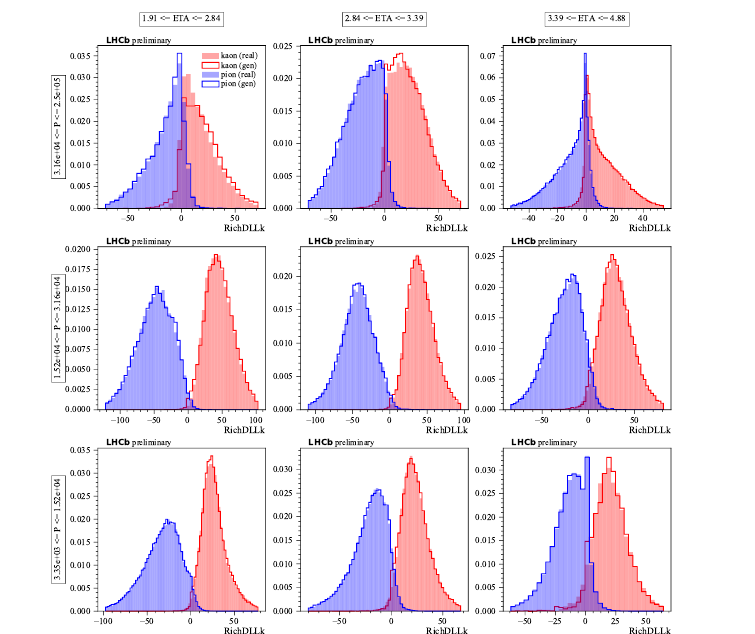
Figure 5: Visual comparison of RICH GAN quality. Weighted real data (filled histograms) and generated (open histograms) distributions of RichDLLk for kaon (red) and pion (blue) track candidates in bins of pseudorapidity (ETA) and momentum (P) over full phase-space.